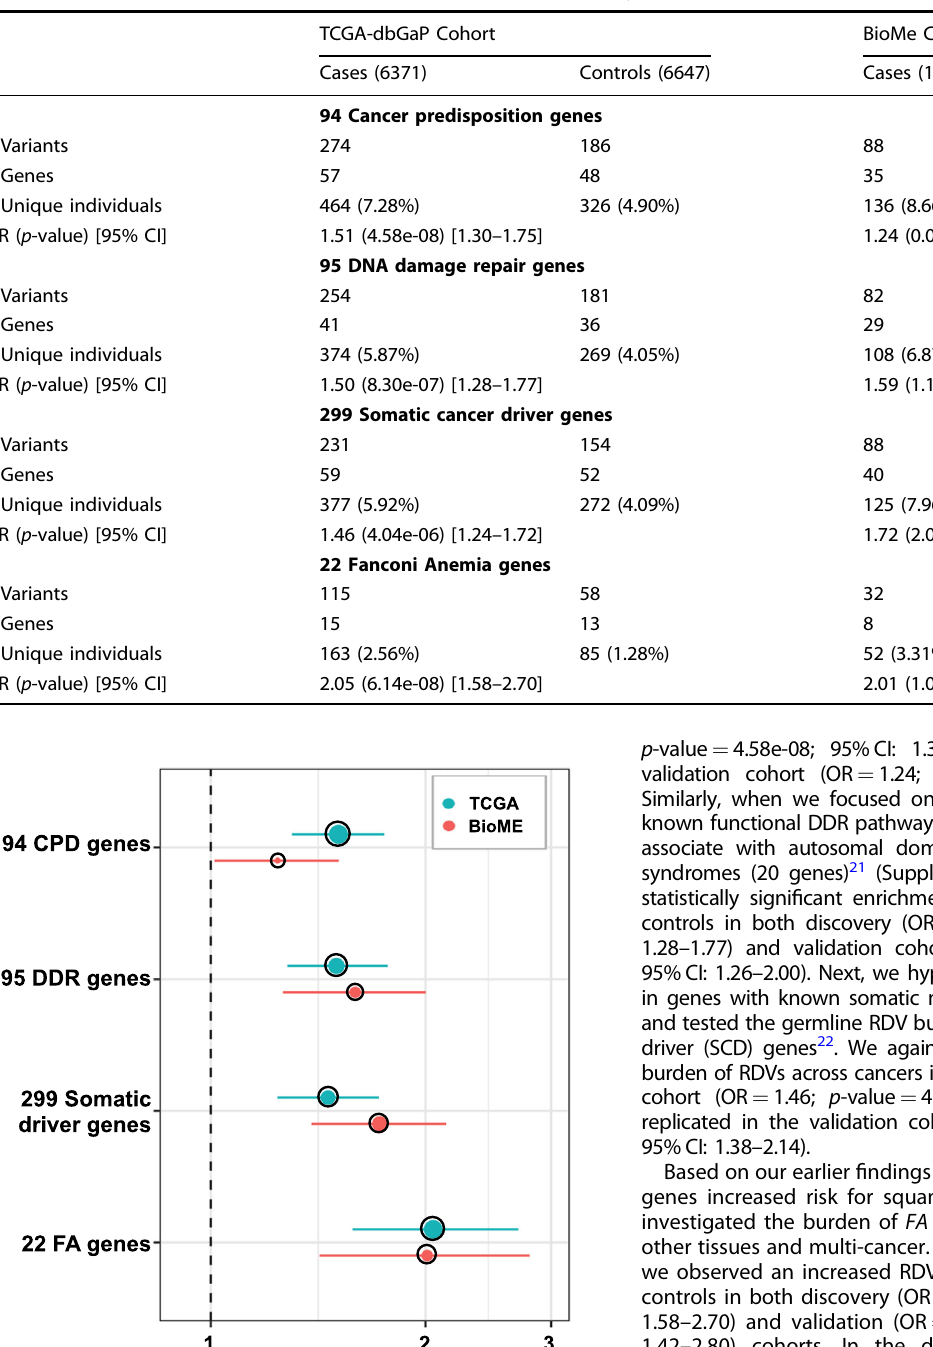
Table 2. Gene-set level rare, deleterious variant (RDV) burden in the study cohorts.